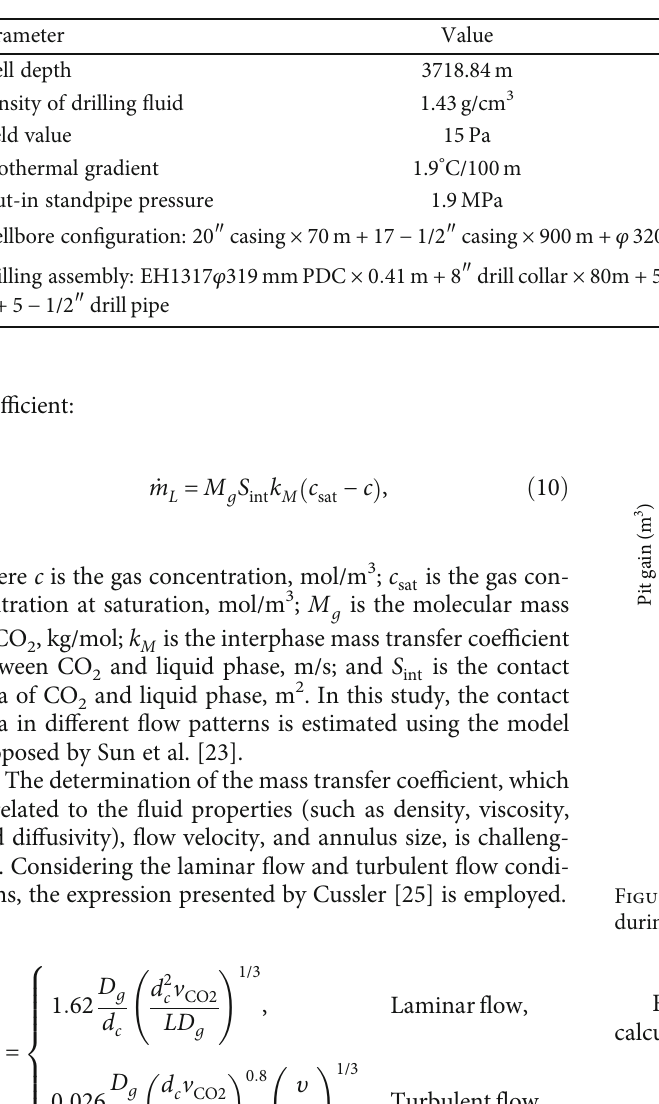
Table 2: Main parameters of the kicking well.